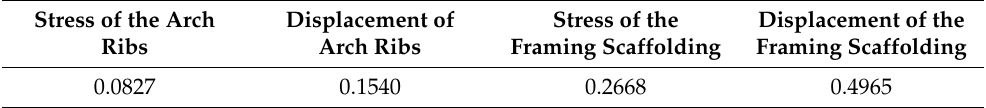
Table 6. Normalized weight of comprehensive evaluation during demolition construction.